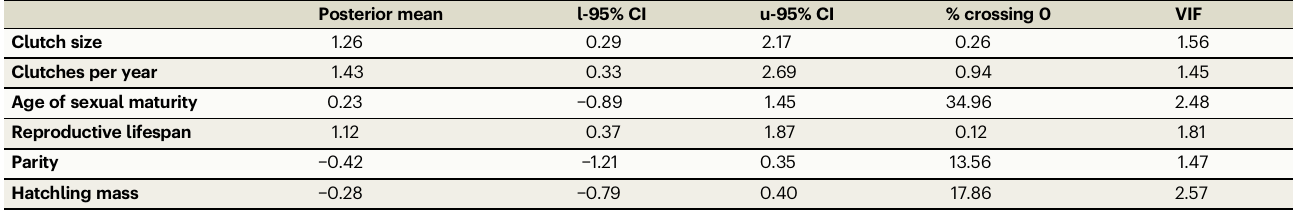
Full parametersformodel predicting introduction within reptiles traded live bytheUS, after iteratively removing variableswith thehighestVIFs until nonewere >5 (bodymass, N =285, H 2 =0.42 [0.05,0.74]).Posteriormean=mean β coef fi cientfromposteriordistributions,l-95%CIandu-95%CI=lowerandupper95%credibleintervalsfromposteriordistributionsrespectively,%crossing zero=percentageofestimates inthe posterior distributionthat overlap with zero in the direction oppositetothe majority of the distribution, VIF variance in fl ationfactors.